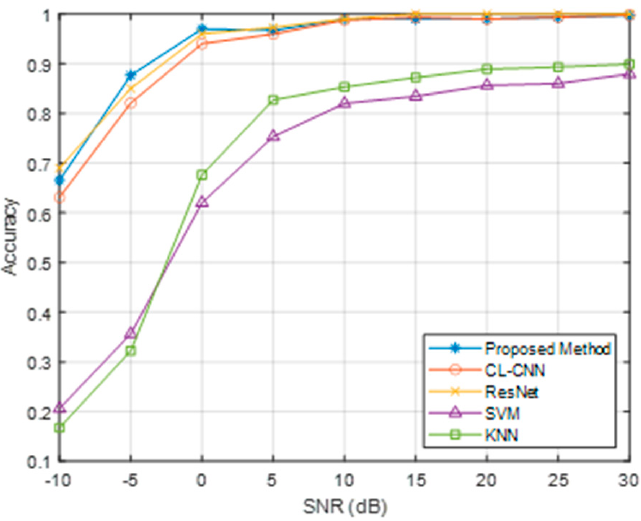
Figure 12. Classification performance comparison with different SNR ( − 10 dB~30 dB).